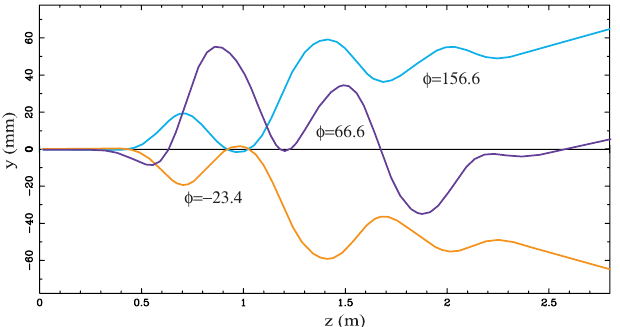
FIG. 4. (Color) Particle trajectories with different input phases ( ’ ) in the LEP cavity when the 446 MHz dipole mode with ¼ 0 : 01 T and the 352 MHz accelerating mode are B max